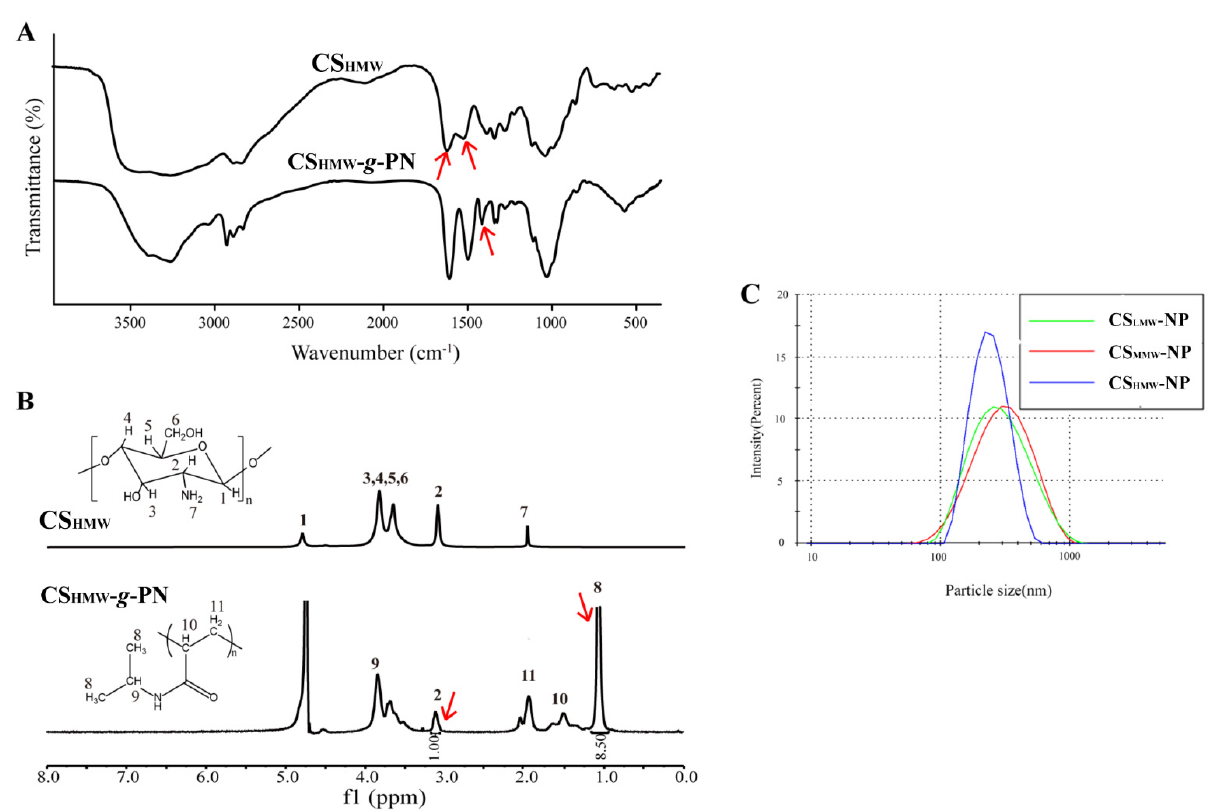
Figure 2. Characterization of CS - g - PN. ( A ) FT-IR spectra of CS HMW and CS HMW - g - PN. The three red arrows illustrate a newly arisen peak in CS HMW - g -PN and two disappeared peaks in CS. The upper two arrows represent peaks at 1640 and 1520 cm − 1 , the lower single arrow represents the peak at 1385 cm − 1 . ( B ) 1 H-NMR spectra of CS HMW and CS HMW - g - PN. Two arrows represent peaks at 3.1 and 1.1 ppm. ( C ) Particle size distribution of CS LMW - NP, CS MMW - NP, and CS HMW - NP.